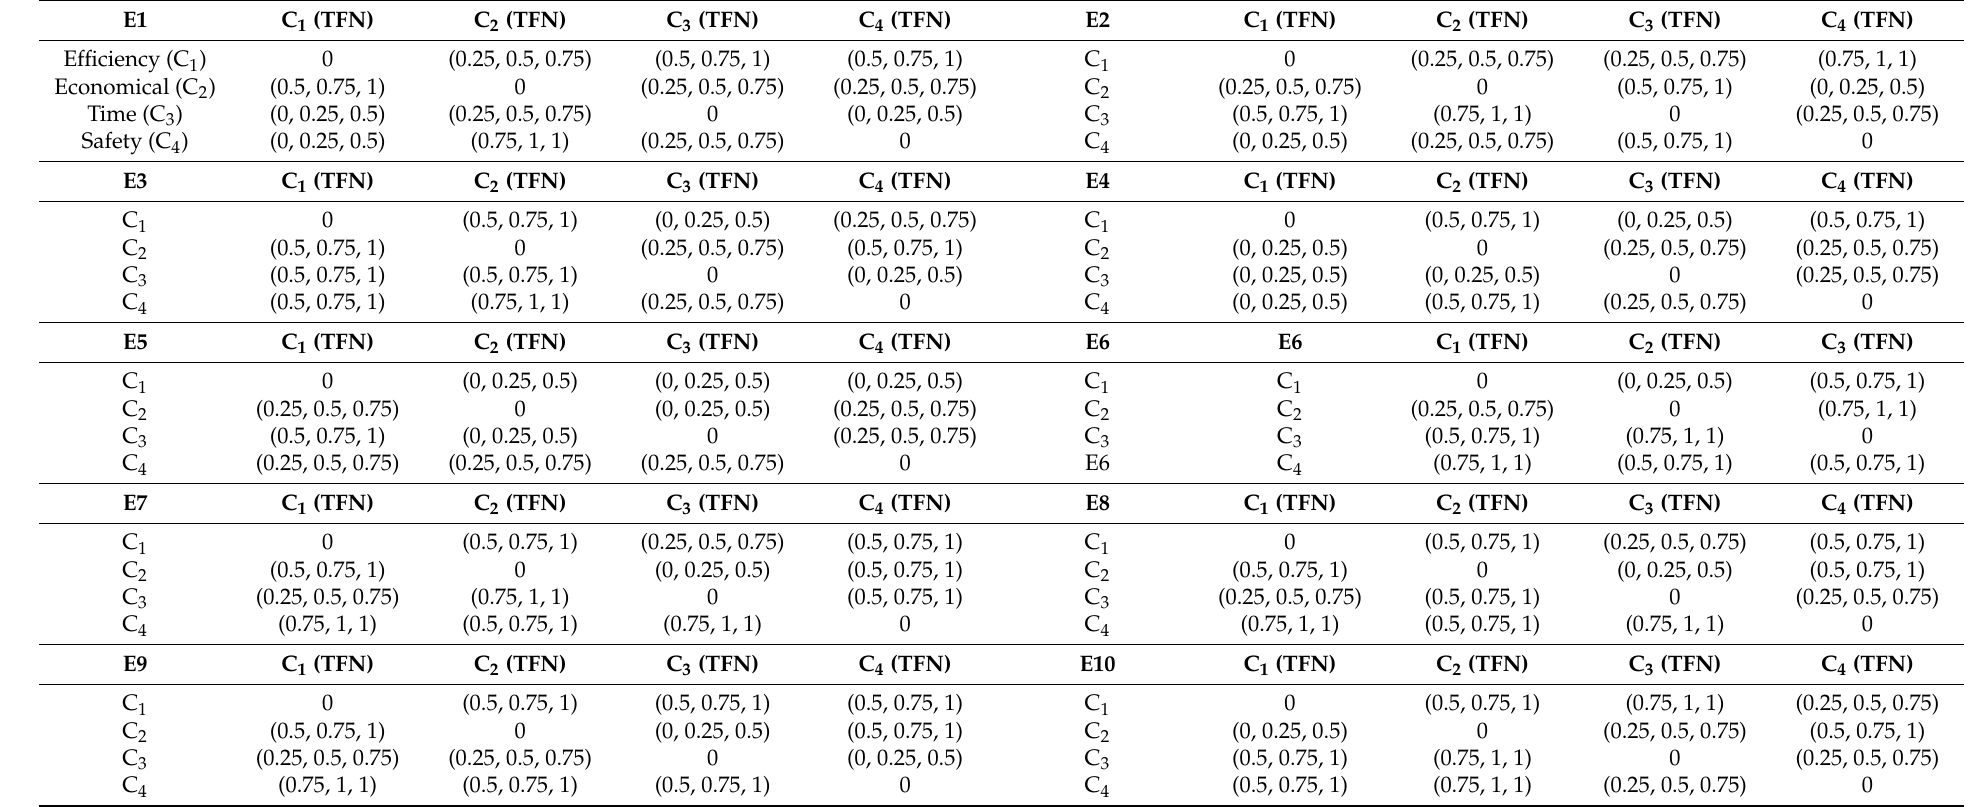
Table A6. The corresponding triangle fuzzy numbers in Table